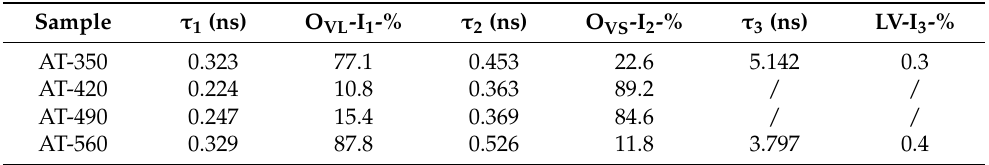
Table 1. Positron lifetime and relative intensities of HAm-TiO 2 − x , where the O VL , O VS , and LV are attributed to lattice O V , surface O V , and large voids,